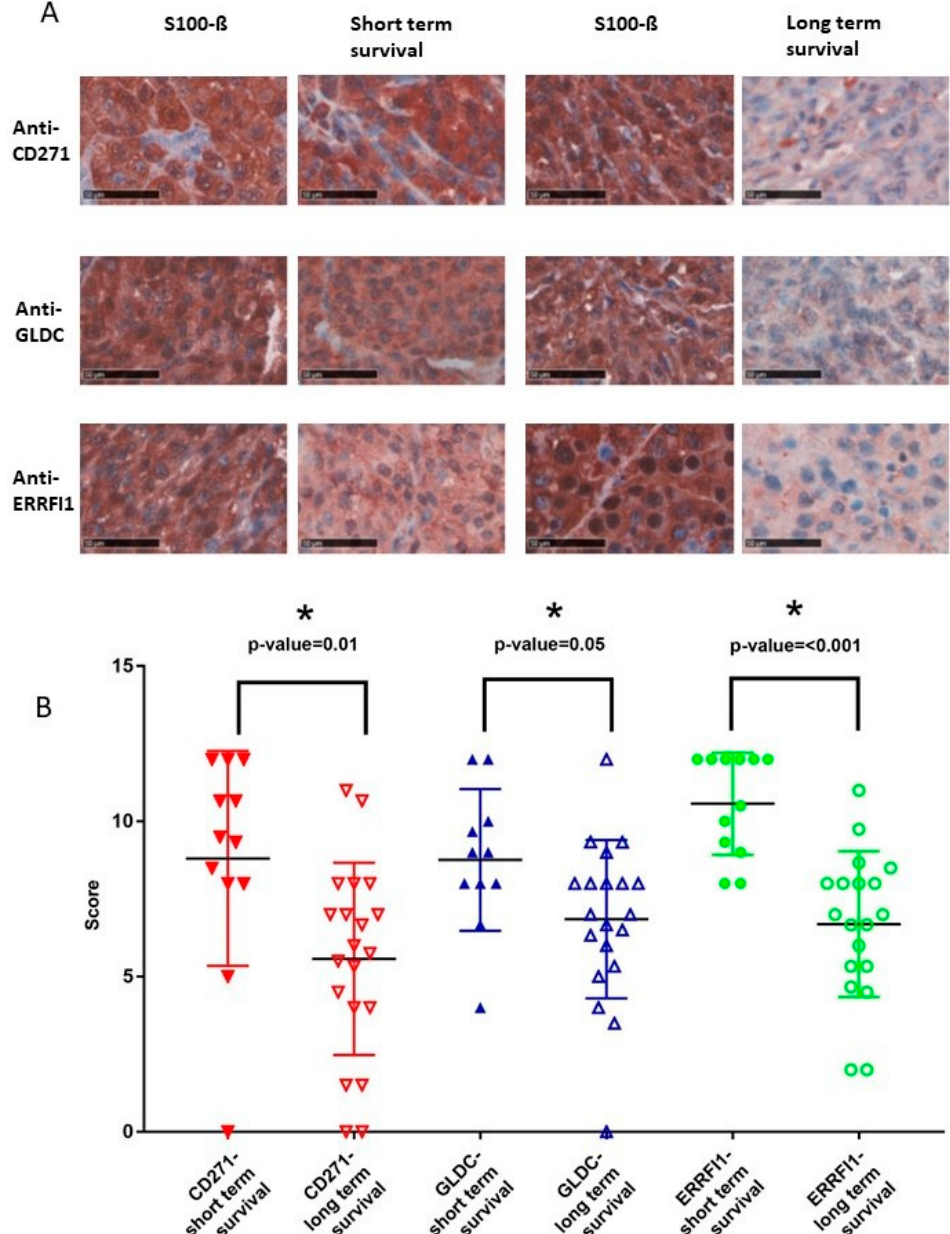
Figure 2. Neural crest marker CD271, GLDC, and ERRFI1 are highly expressed in advanced melanoma patients with bad prognosis. ( A ) Immunohistochemical stainings for CD271, GLDC, and ERRFI1 for short-term survival and long-term survival. Scale bar: 50 µm. ( B ) Overall IHC score analyses for CD271, GLDC, and ERRFI1 for short- and long-term survival. Y-axis shows the overall IHC score (0–12), which was calculated from the means of the products of quantity and intensity of the stainings. The displayed antibodies showed p -values < 0.05 (*) analyzed with two-tailed t -test. 2.3. High TWIST and GLDC Protein Expression are Associated with Metastasis Development in High-Risk